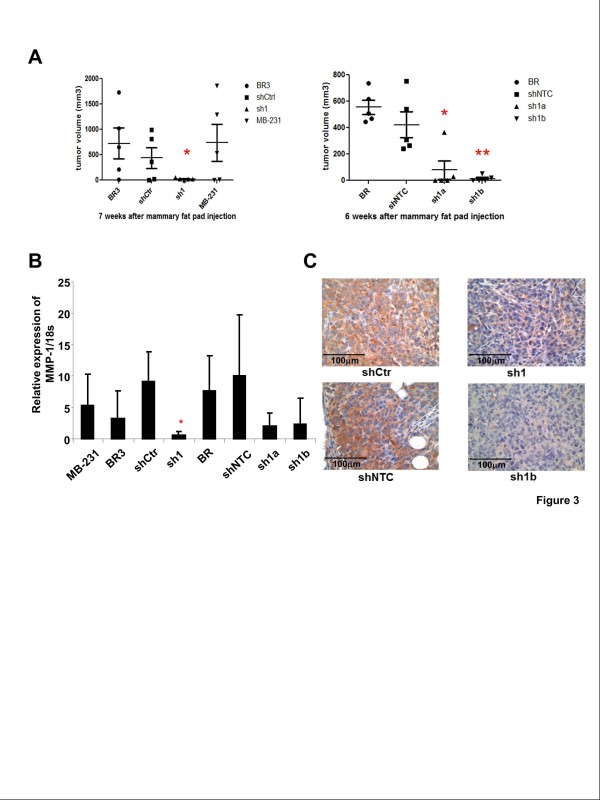
Stable knockdown of MMP-1 expression inhibits local tumor growth. A, each cell line was injected into mammary fat pads of nude mice (5×106 cells per mouse). Each group includes five mice. Asterisks indicate that the tumors of MMP-1 knockdown cell line sh1 grew significantly slowly than the control cell line shCtr (P < 0.05, t-test) and the tumors of MMP-1 knockdown cell lines sh1a and sh1b grew significantly slowly than those of the control cell line shNTC (P < 0.01, ANOVA Dunnett’s Multiple comparison test). B, real-time PCR quantification of MMP-1 mRNA levels of tumors showed a significant reduction in tumors of sh1 cells compared with shCtr tumors. C, representative MMP-1 immunohistological staining of tumor sections showing reduced staining in sh1 and sh1b tumors.